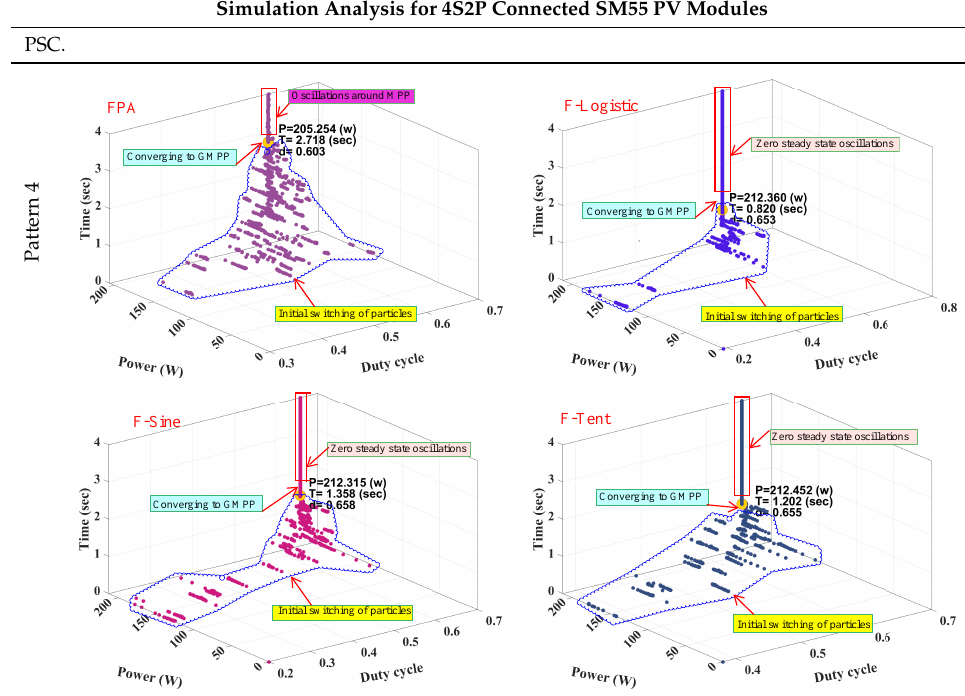
Table 5. Simulated mean power, and duty cycle of FPA and FC-FPA variants over number of runs for patterns 4, and 5 of the 4S2P connected SM55 PV